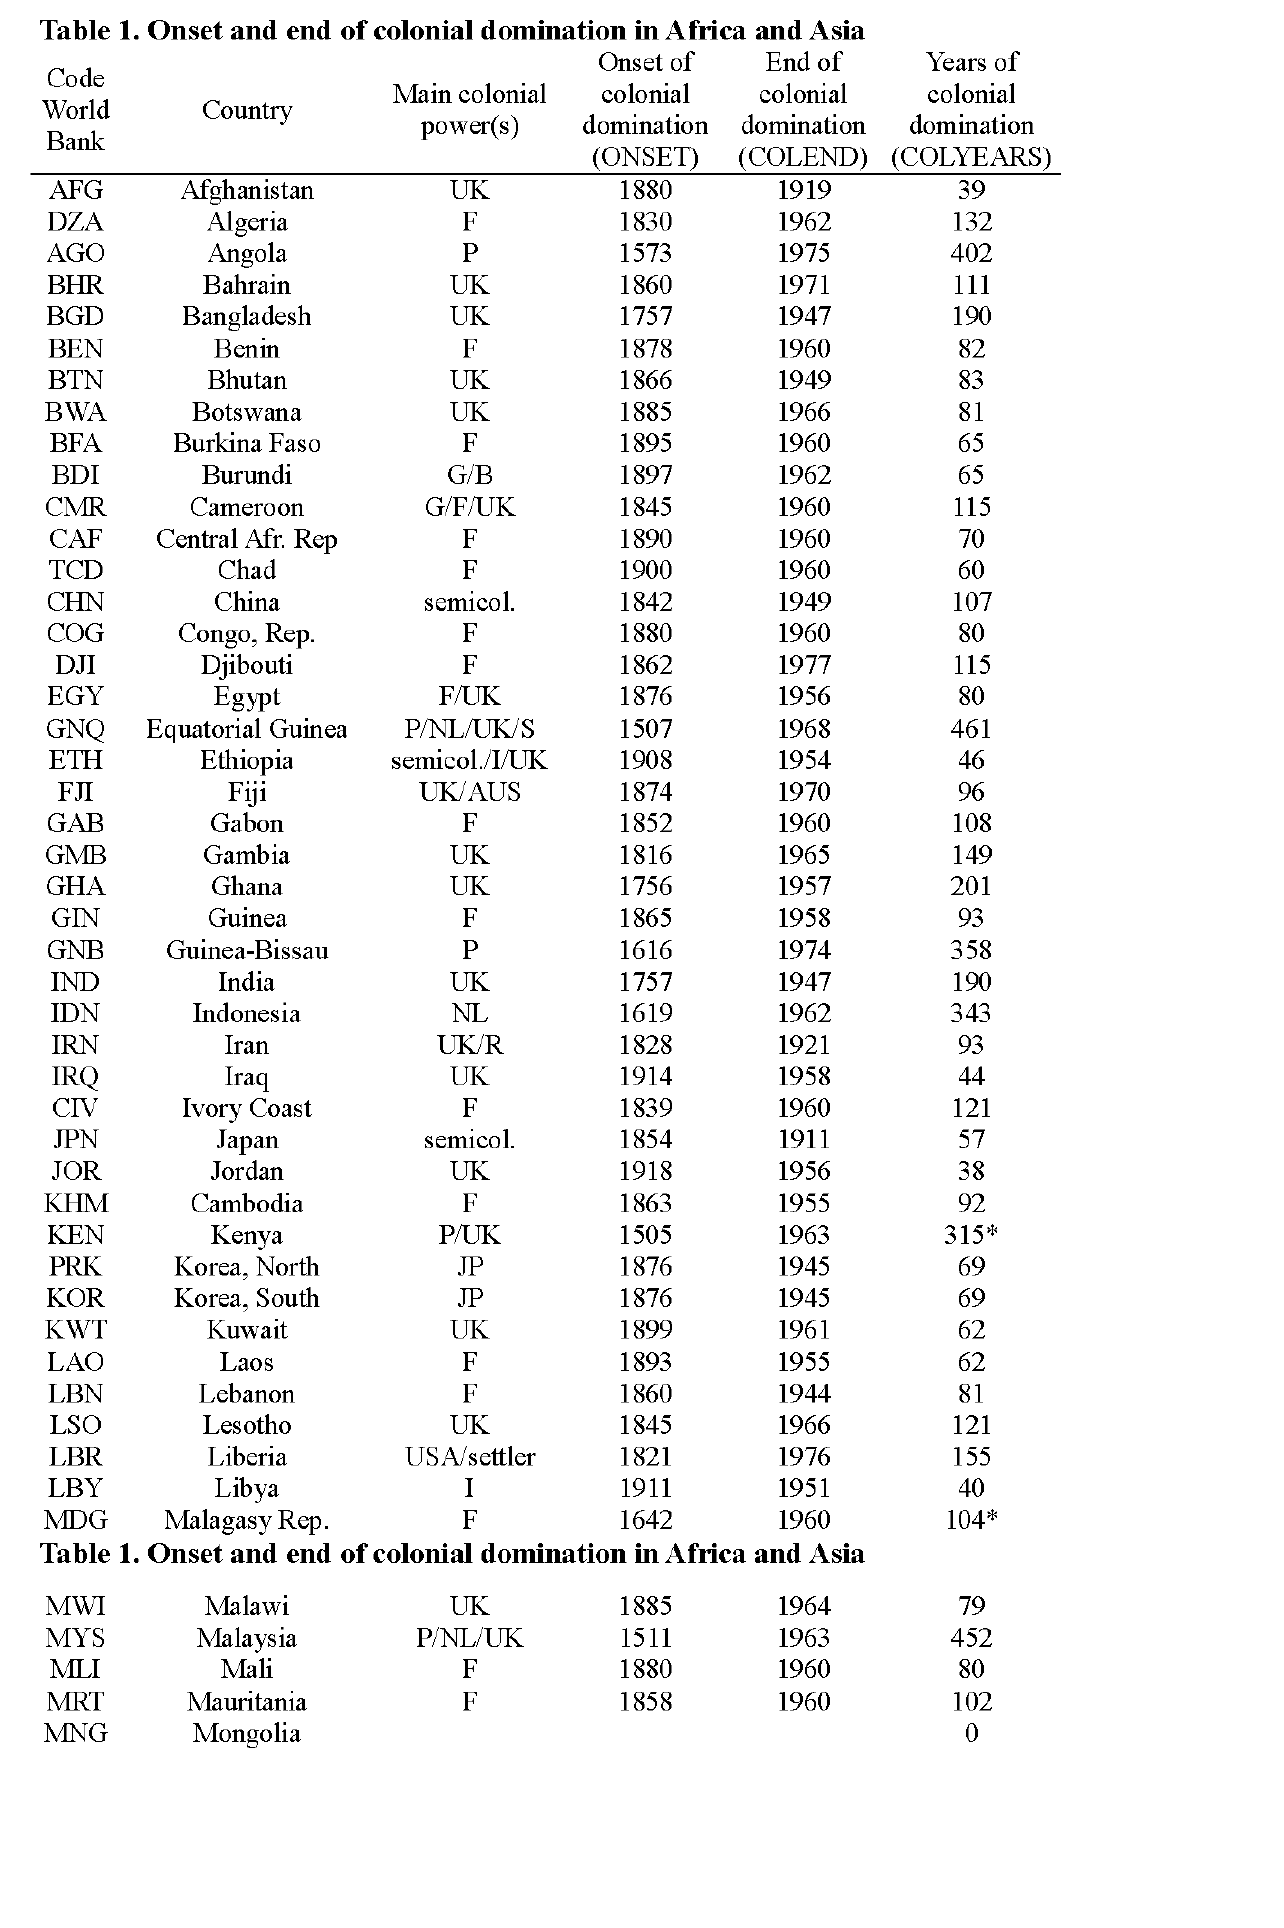
Table 1. Onset and end of colonial domination in Africa and Asia